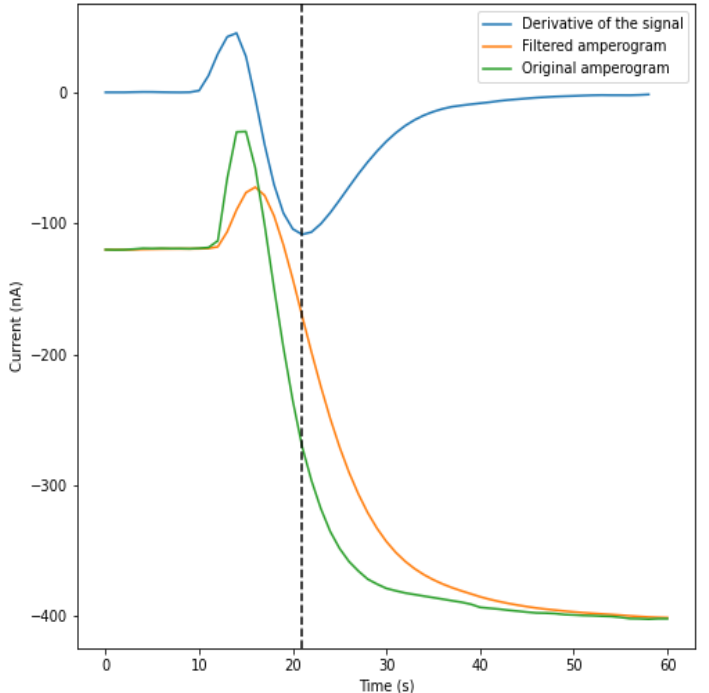
Figure 7. Finding the inflection point of the signal. The original signal, filtered signal and the derivative of the first order are represented. The inflection point obtained by the derivative is represented by the vertical dotted line.